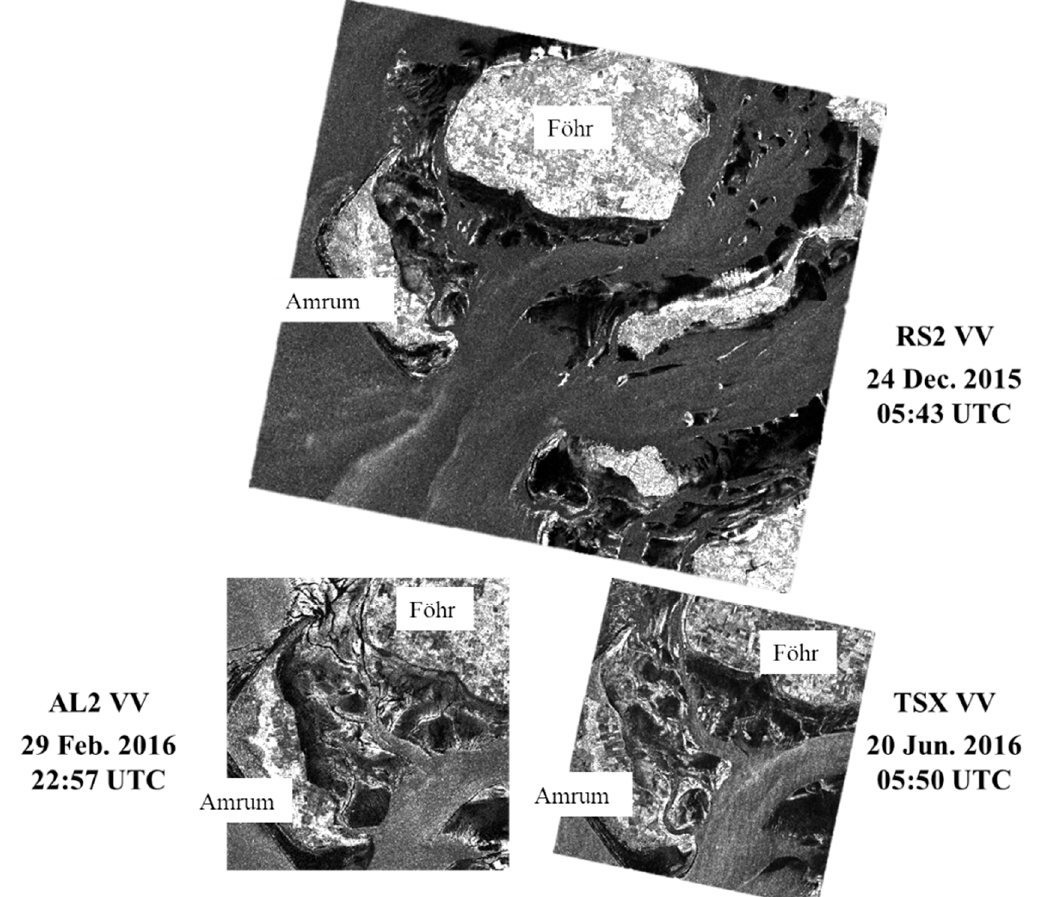
Figure 4. VV-polarization Synthetic Aperture Radar (SAR) imagery of the study area, acquired by Radarsat-2 (RS2; top ; 29.6 km × 31.7 km), ALOS-2 (AL2; bottom left ; 18.2 km × 18.2 km), and TerraSAR-X (TSX; bottom right ; 18 km × 16 km). All SAR images were acquired shortly after low tide. RS2: © MacDonald, Dettwiler and Associates Ltd. 2015—All Rights Reserved; AL2: © JAXA 2016; TSX: © DLR 2016. Table 1. SAR acquisition dates and times, sensors and radar bands, acquisition modes, and environmental conditions during image acquisitions. Water levels are geopotential heights measured at pile “Wittdün”. Polarizations: dual-co-pol HH + VV (D), quad-pol HH + HV + VH + VV